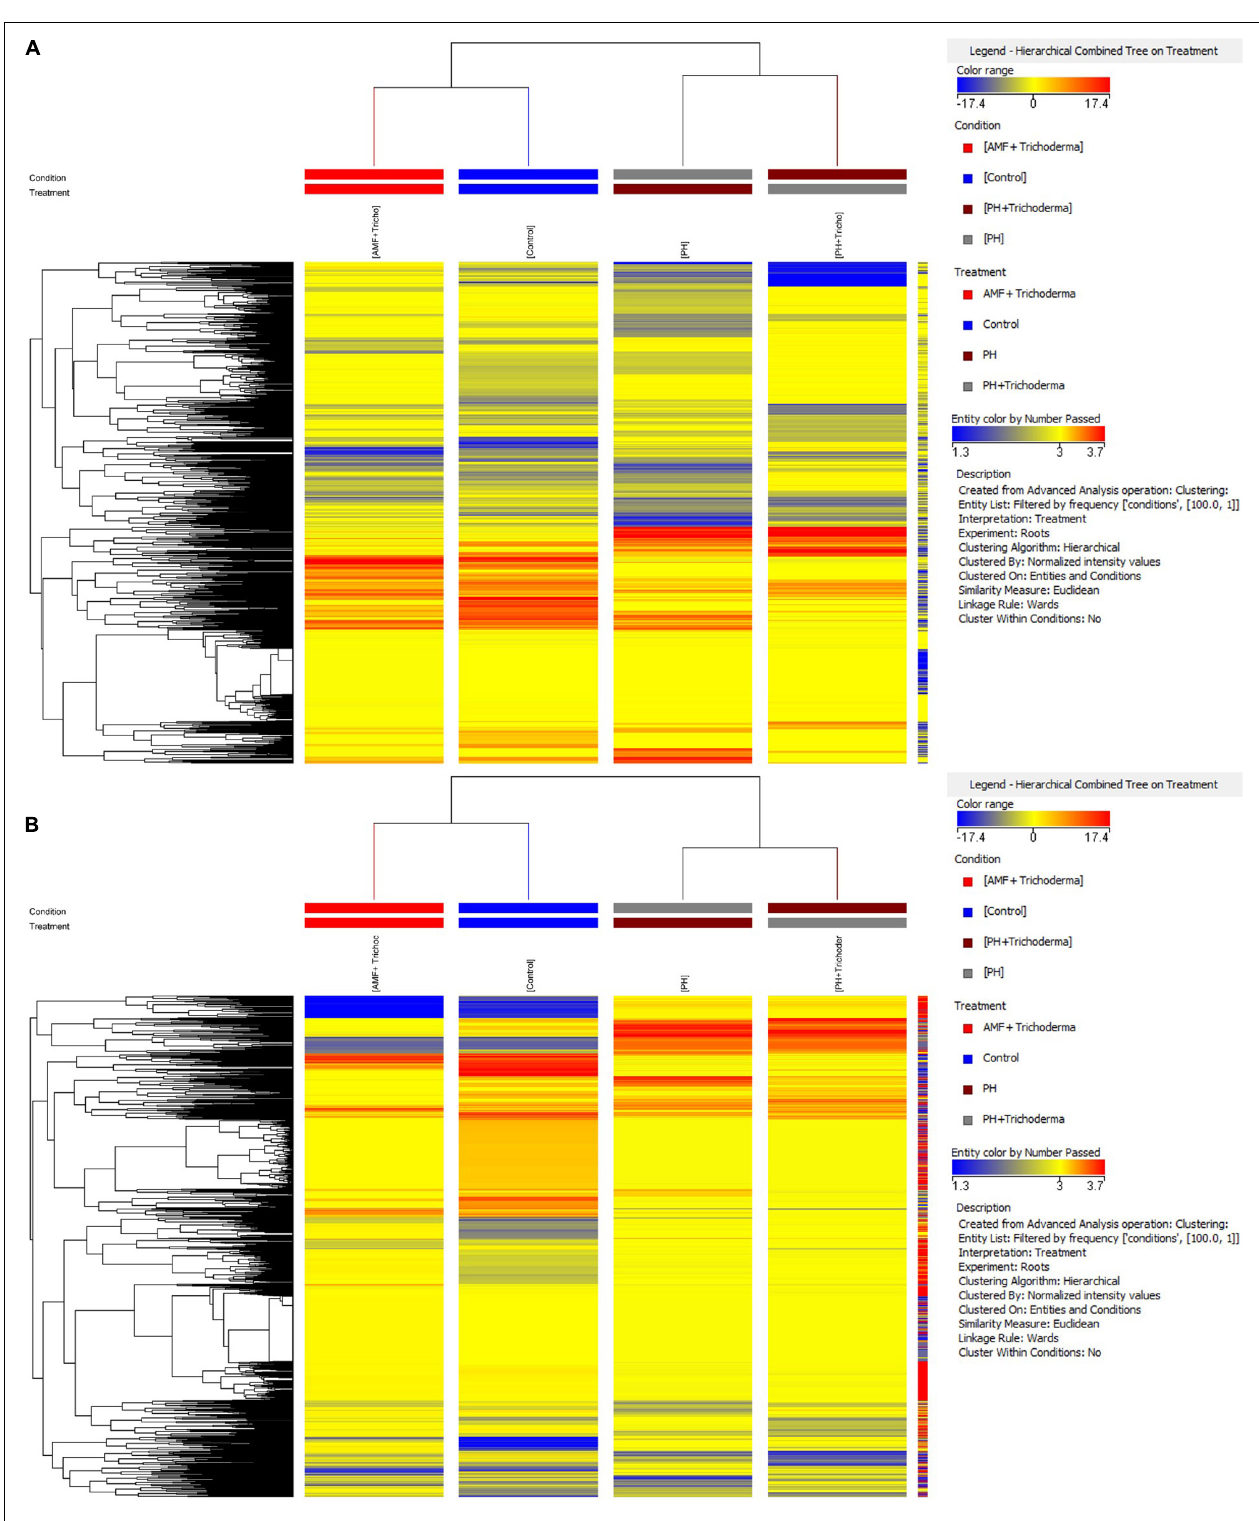
FIGURE 1 | Unsupervised hierarchical cluster analysis carried out from UHPLC-ESI/QTOF-MS metabolomic analysis of leaves (A) and roots (B) of maize plants treated with a consortium of arbuscular mycorrhizal fungi (AMF), Trichoderma koningii TK7, and rhizosphere bacteria or with a consortium of Trichoderma koningii TK7 and rhizosphere bacteria (Tricho) plus a protein hydrolyzate-based biostimulant (PH), or with a protein hydrolyzate-based biostimulant (PH). The fold-change based heat map was used to build hierarchical clusters (linkage rule: Ward; distance: Euclidean).